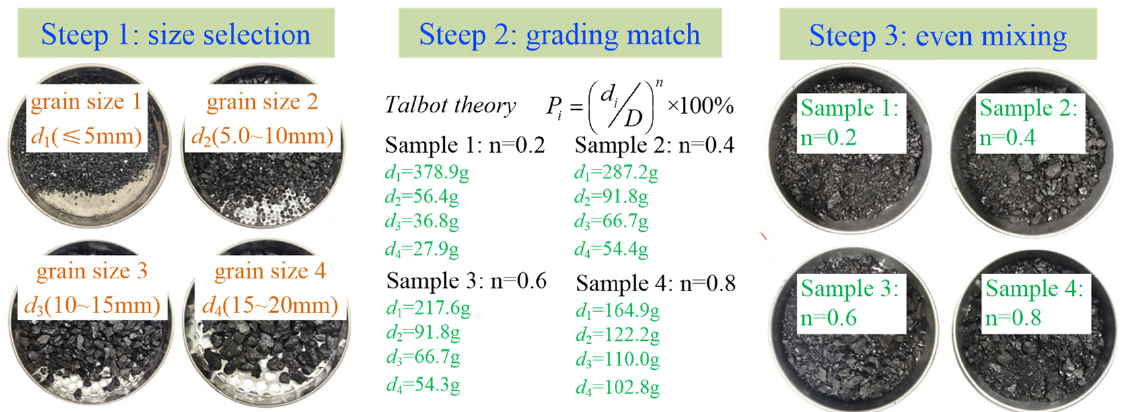
Figure 3. Percentage of particles and preparation process of samples with different grading structures.